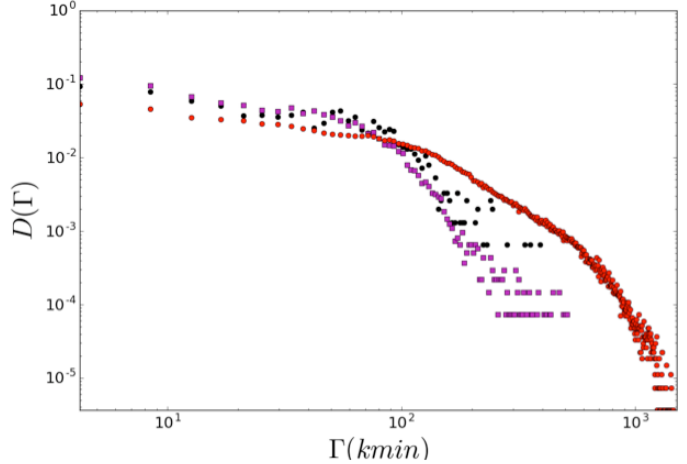
1, N 2 and heuristic cases − −